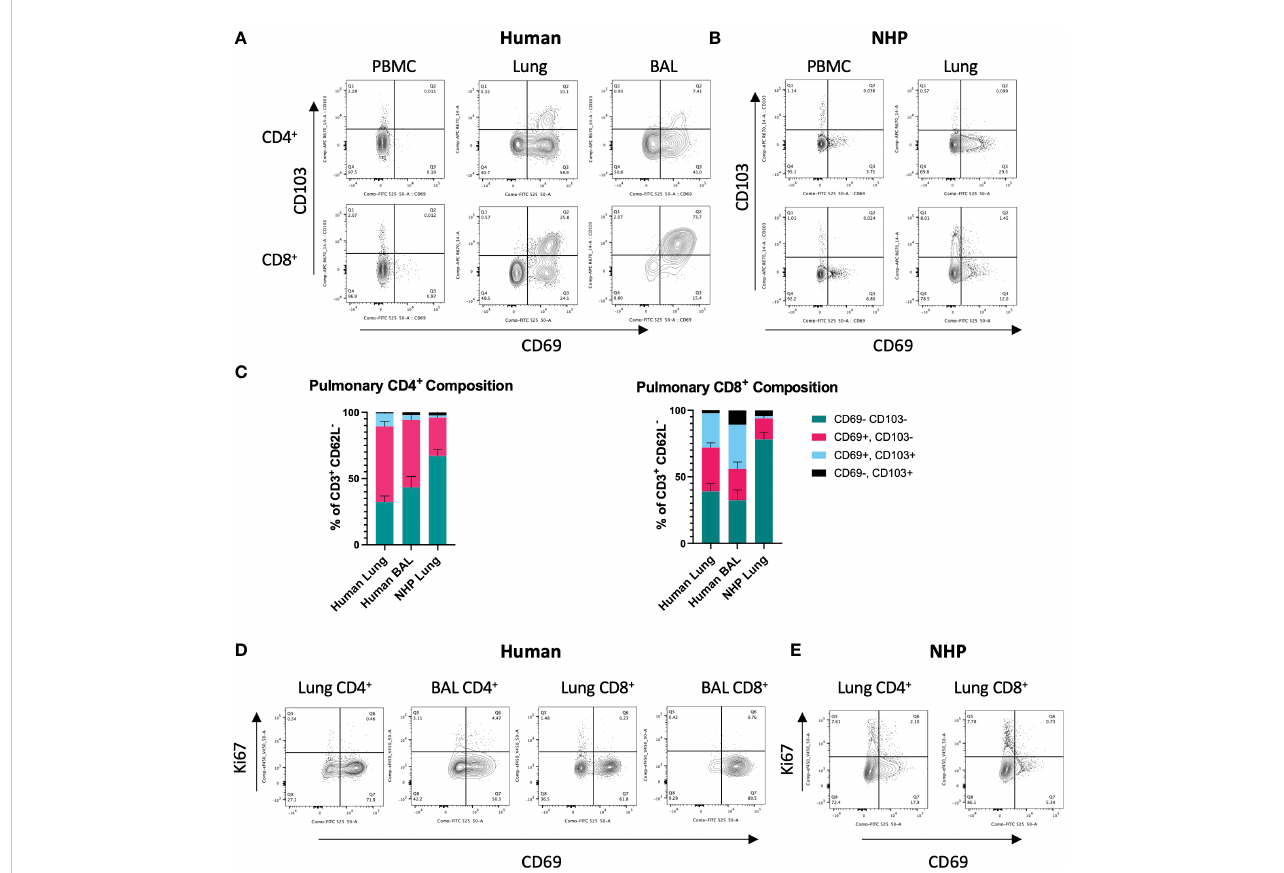
FIGURE 1 Characterisation of Human and NHP Pulmonary T RM. T RM from BAL and/or tissue digests were compared with peripheral T cells. (A) Identi fi cation of human pulmonary CD4 + and CD8 + T RM . T RM (live, CD3 + , CD4 + /CD8 + , CD62-L - ) were identi fi ed based on their expression of CD69 and CD103. (B) Identi fi cation of NHP CD4 + and CD8 + T RM . (C) Proportion of CD69 + and CD69 + CD103 + T RM in human and NHP lung. (D) Ki-67 staining in human CD4 + and CD8 + T RM . (E) Ki-67 staining in NHP CD4 + and CD8 + T RM . Human and NHP samples were concatenated for analysis. Data represented as representative fl ow cytometry plots or compiled frequencies with mean ± SEM (C) from human lungs (n=15), BAL (n=9) and NHP lung